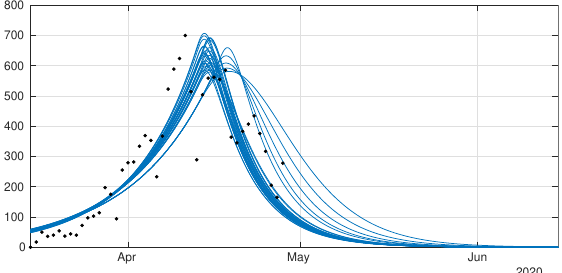
Figure 8. Cumulative number of cases. We plot the cumulative data (reds dots) and the best fits of the model CR ( t ) (black curve) and CU ( t ) (green curve). We fix f = 0.8, 1/ η = 7 days and 1/ ν = 7 and we apply the method described in Liu et al. [29]. The best fit is d 1 = 2 April, d 2 = 5 April, D = 27 April, µ = 0.6, χ 1 = 179, χ 2 = 0.085, χ 3 = 1 and t 0 = 13 January.